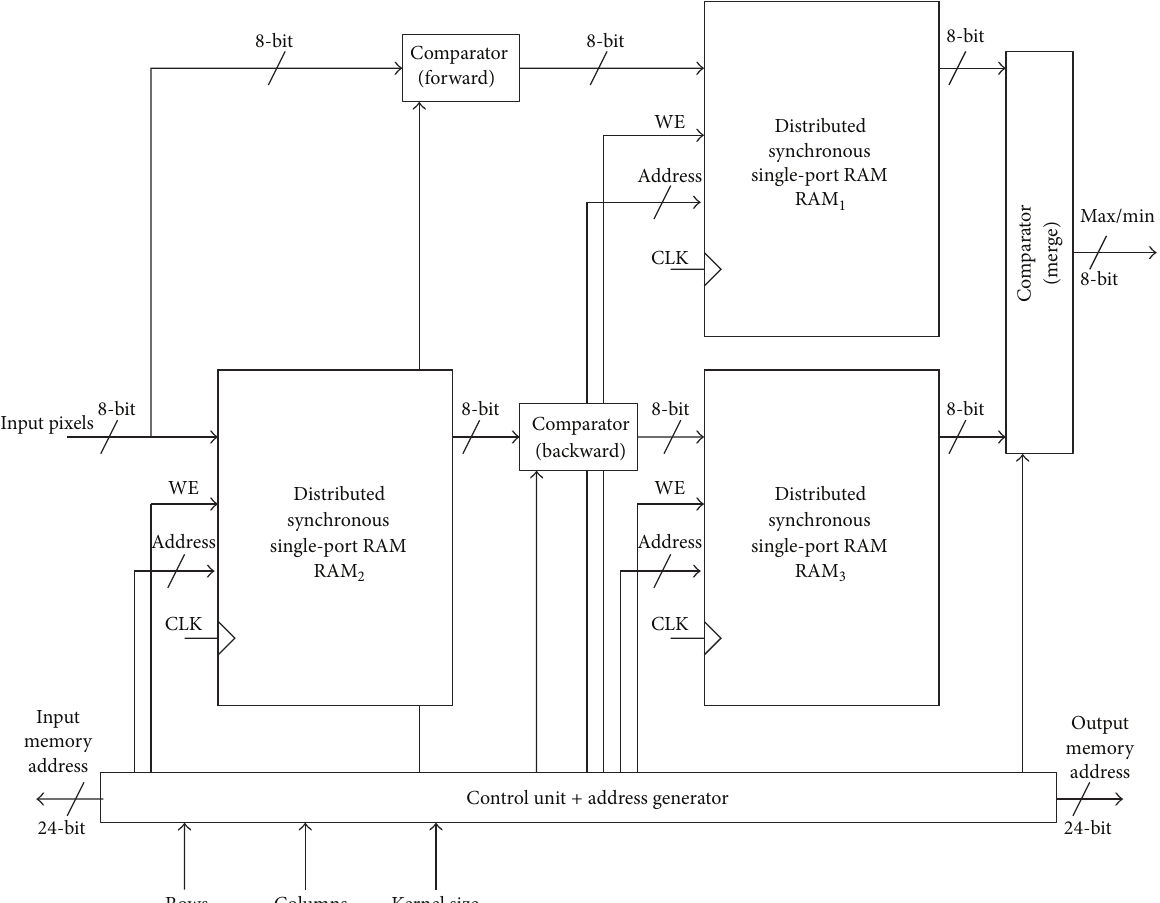
Figure 2: Block diagram of the proposed hardware architecture for running max/min filters based on the HWG algorithm and its main components.